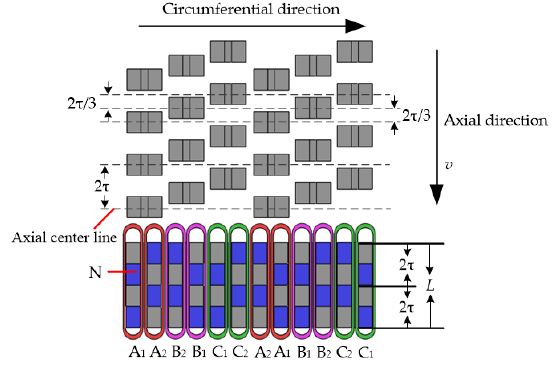
Figure 3. Outspread diagram of the machine topology.